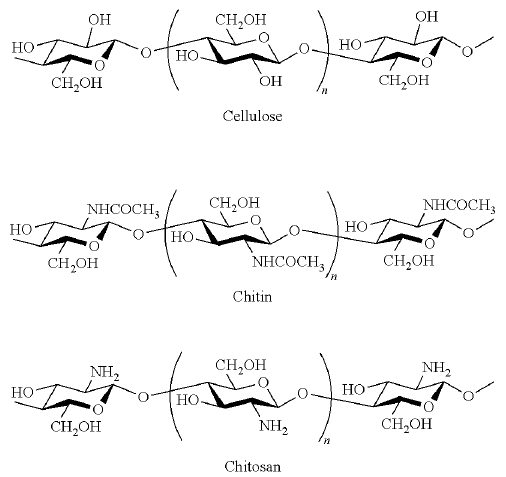
Figure 8. Chitin, Chitosan, and Cellulose chemical